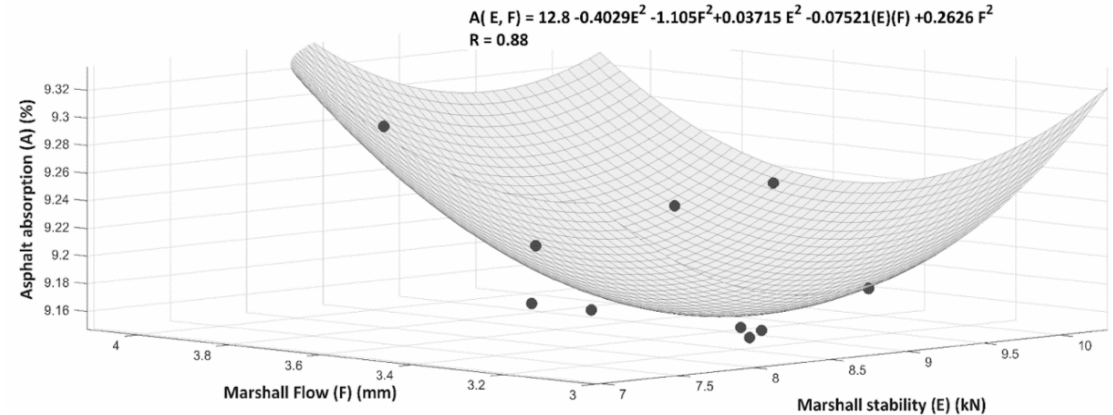
Figure 18. Correlation between Marshall stability, Marshall flow and percentage of asphalt absorption (Mixture with 30%